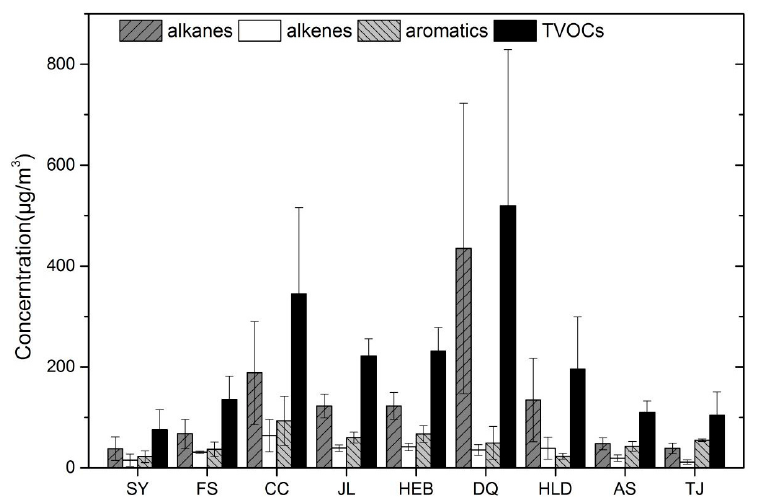
Figure 2. Concentrations of VOCs groups (alkane, alkene and aromatics) measured in nine cities